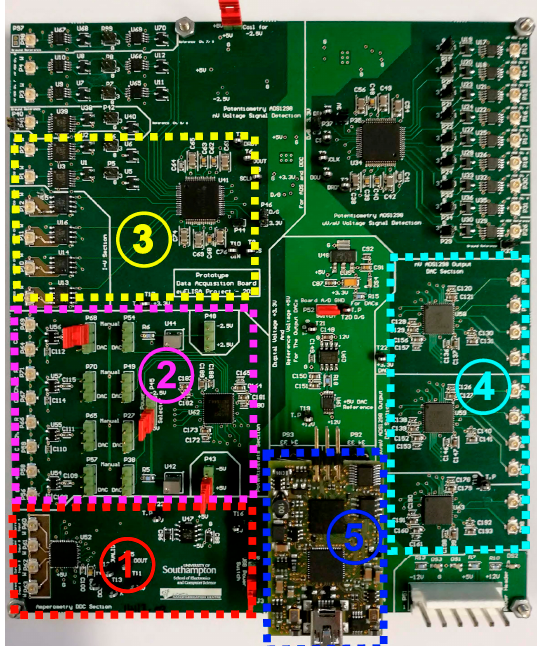
Figure A1. The proposed, fabricated bioinstrumentation board with its five distinct compartments.